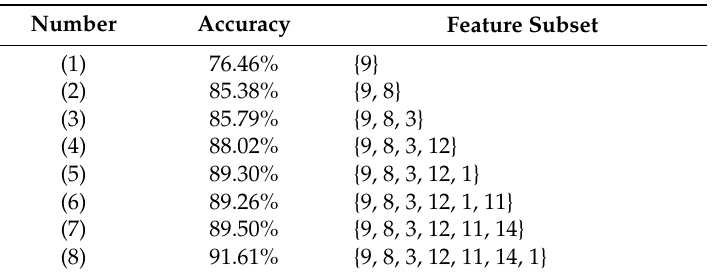
Table 3. Selection of shape features .